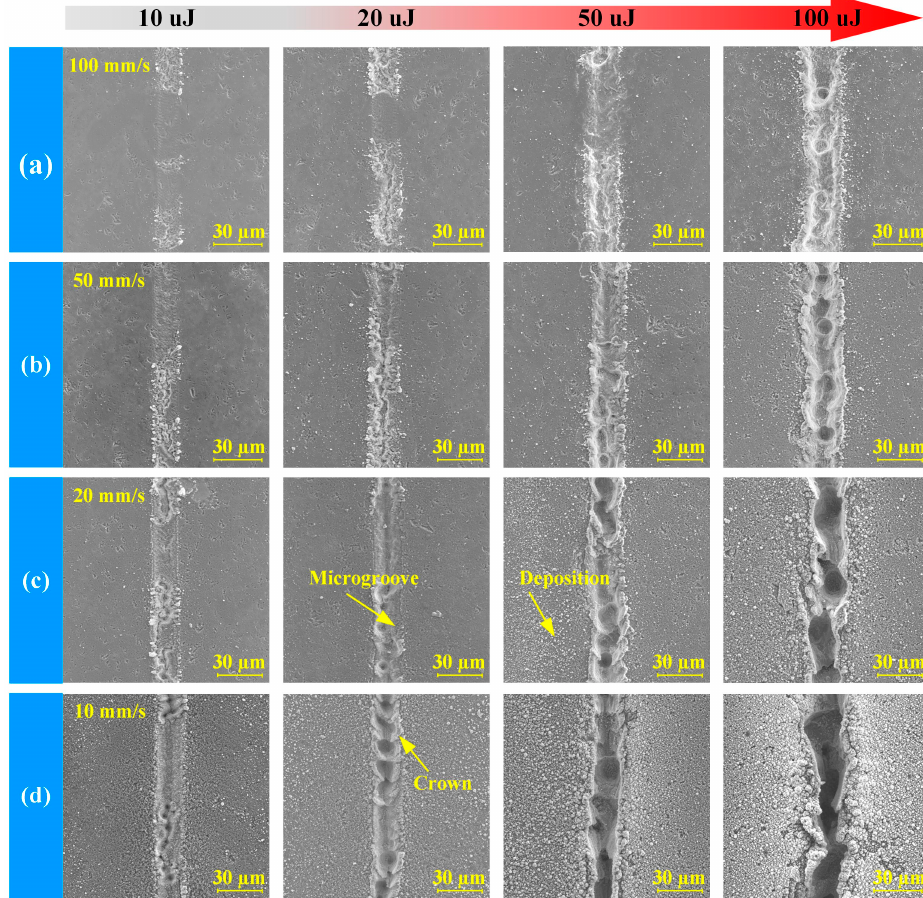
Figure 4. SEM image of different scanning speeds. ( a – d ) From 100 mm/s to 10 mm/s.